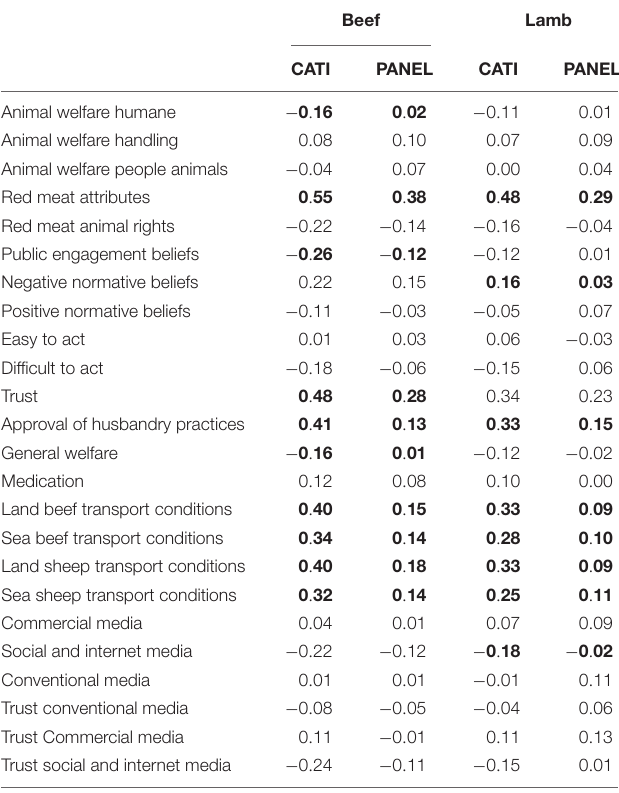
TABLE 10 | Correlations (df = 1030) between beef and lamb consumption and all composite variables.